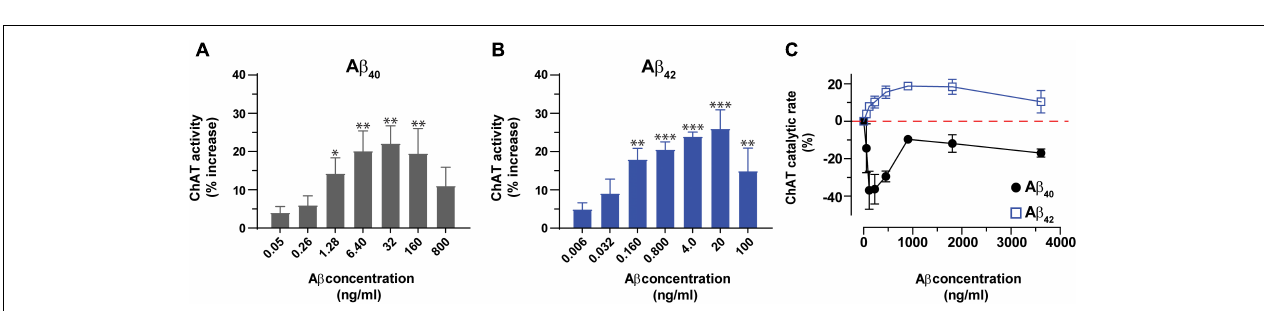
FIGURE 1 | Novel real-time kinetic ChAT assay for direct monitoring of the enzyme catalytic activity. ChAT was incubated with physiological concentrations of A β peptides in 96-well plates and real-time changes in ChAT activity were monitored using our newly designed fluorometric assay, as described in the “Materials and Methods” section. The graphs in (A,B) show the measured rate of ChAT ( (cid:49) RFU/min) in the wells in the presence and absence of 6.4 ng/mL A β 40 and 0.16 ng/mL A β 42, respectively. ChAT activity showed a rate of 36.5 ± 1.48 (cid:49) RFU/min and 71.6 ± 1.41 (cid:49) RFU/min in the presence of A β 40 and A β 42, respectively. These slopes were statistically significant compared to slopes of ChAT activity for control, i.e., in the absence of A β 40 (26.1 ± 1.1 (cid:49) RFU/min) and A β 42 (53.8 ± 1.1 (cid:49) RFU/min). The values are shown as mean ± SD of ≥ 2 readings. ∗∗∗ p -value < 0.0001 compared to control (no A β ). (C) The effect of different concentrations (0.167% and 1.67%) of DMSO on ChAT activity was also monitored to ensure that the low DMSO content in experimental wells, resulting from diluting A β stocks, does not interfere with the ChAT assay. The analysis indicated that DMSO had no significant effect on ChAT activity. The values are shown as mean ± SEM of three readings.